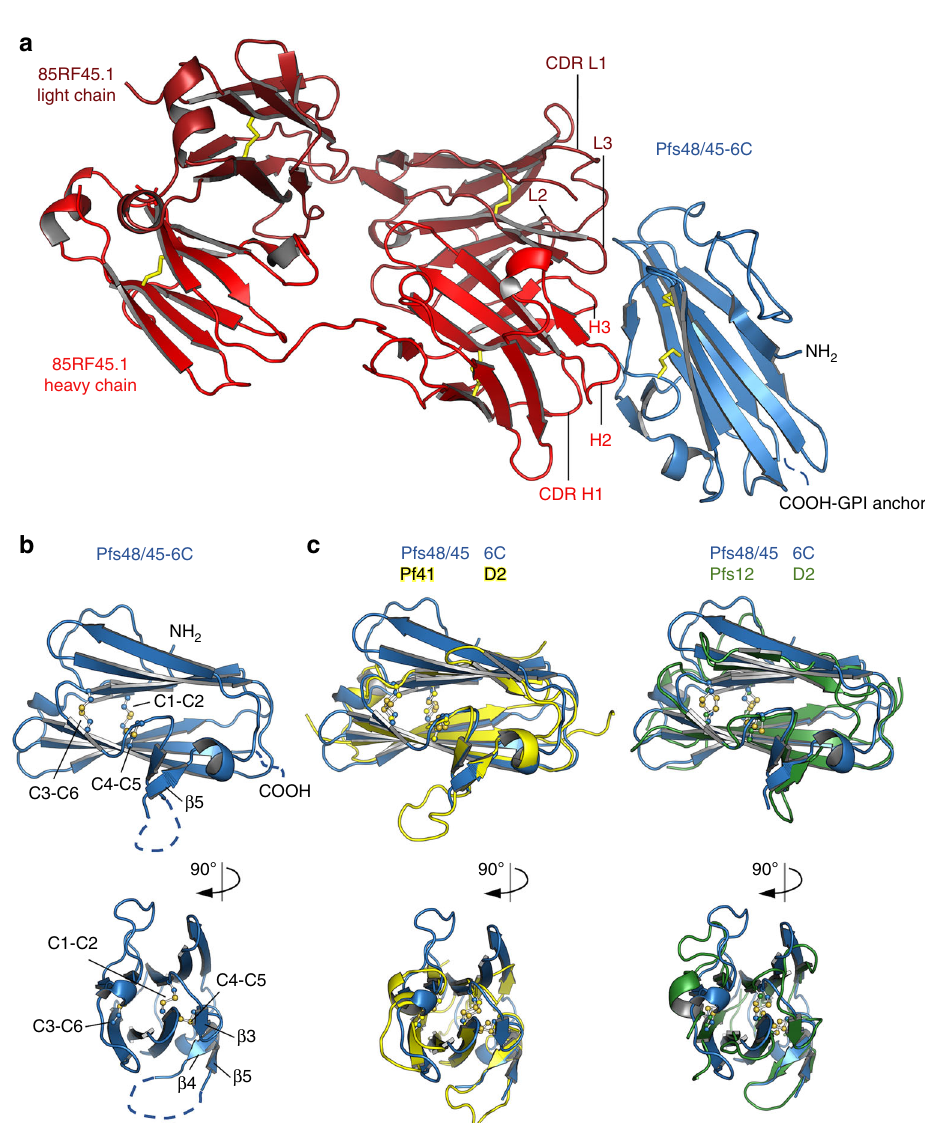
Fig. 4 The structure of Pfs48/45-6C bound to a Fab fragment of the transmission-blocking mAb 85RF45.1. a The structure of Pfs48/45 (blue) bound to 85RF45.1 Fab fragment (red). The light (dark red) and heavy chains (light red) are indicated. Disulphide bonds are shown in stick representation. b Disulphide bond pattern within Pfs48/45-6C, numbered as in Fig. 1A. A disordered loop connecting β -sheet 4 and 5 is indicated by dashed lines. c Overlay of Pfs48/45-6C with the C-terminal 6-cys domains of Pf41 (PDB code 4YS4) and Pf12 (PDB code 2YMO). Pfs48/45 6C and Pfs41 D2 were structurally aligned over 62 C α atoms, Pfs48/45 6C and Pfs12 D2 were aligned over 60 C α